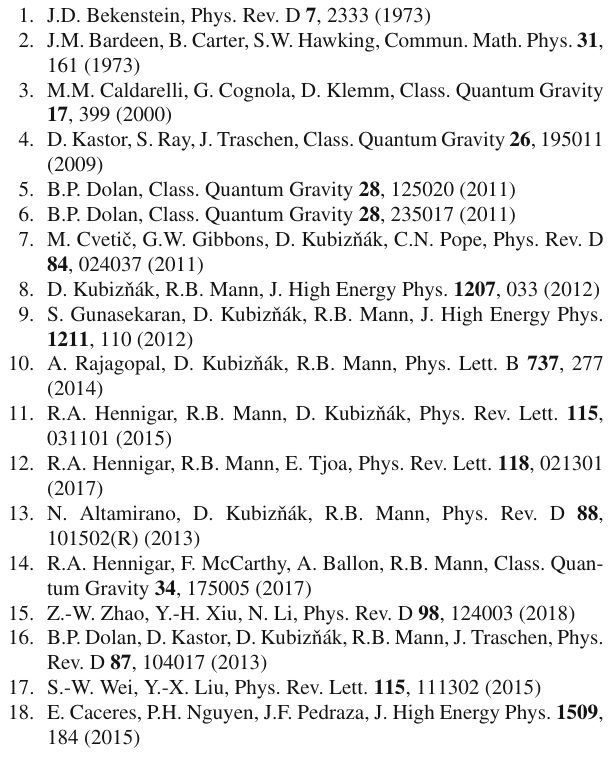
Fig. 14 The T HP – p and G – T curves of the RN–AdS black holes with the GB term in the canonical ensemble with fixed charge